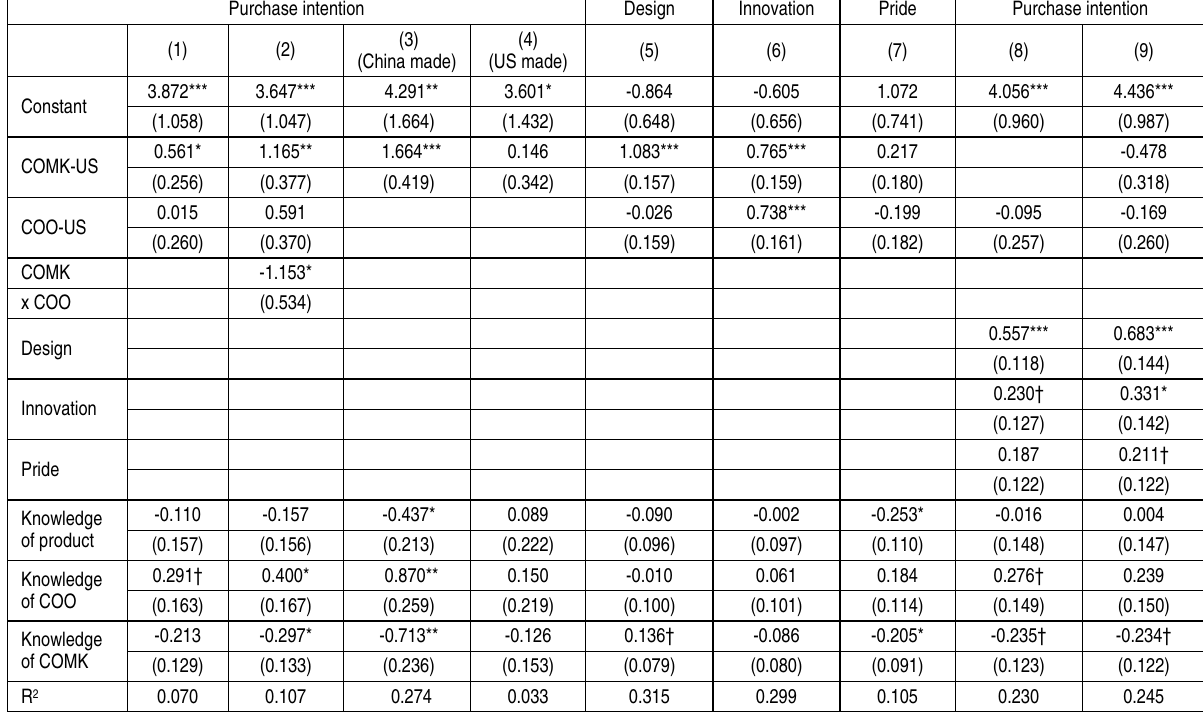
Table 2. The result of COMK effect on consumer purchase